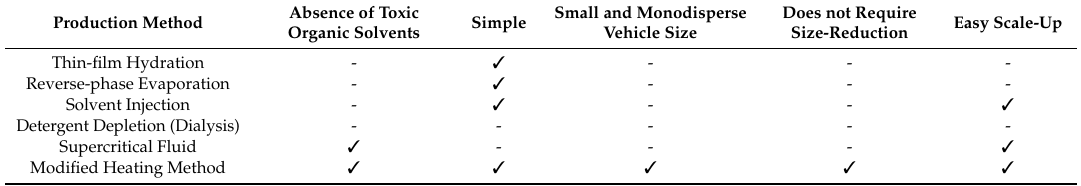
Table 6. Advantages and disadvantages of various methods that produce lipidic vehicles and liposomes. Production